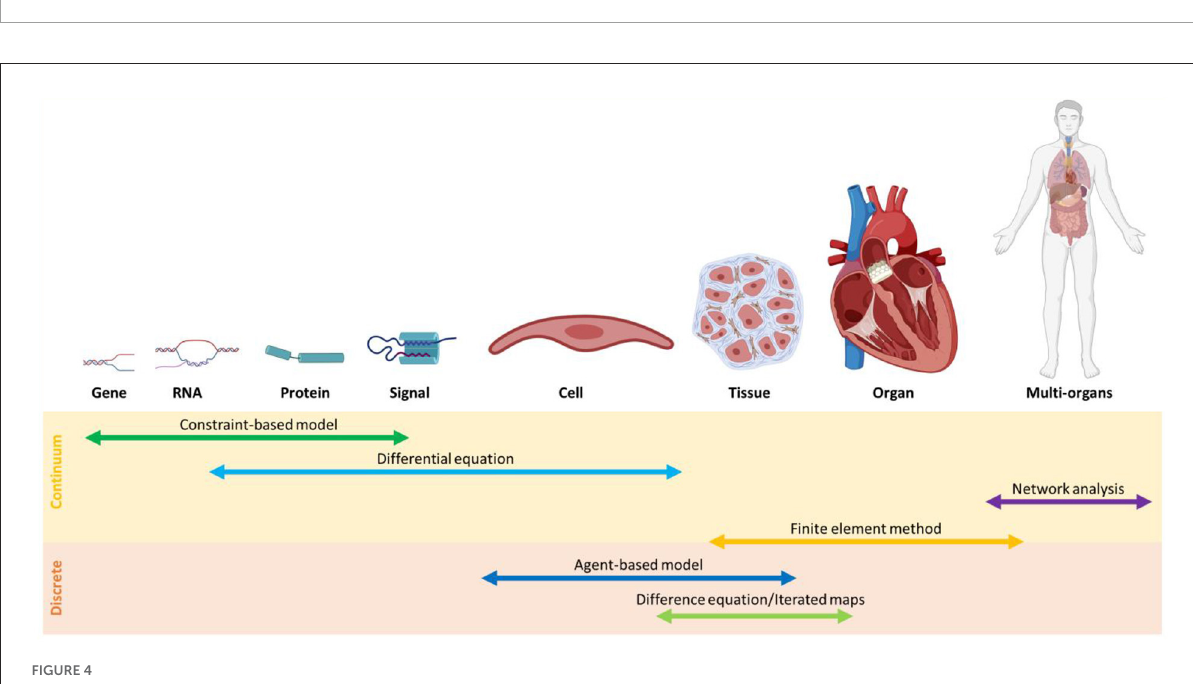
FIGURE4 An overview of modeling methods at different scales classified, into continuum and discrete models.